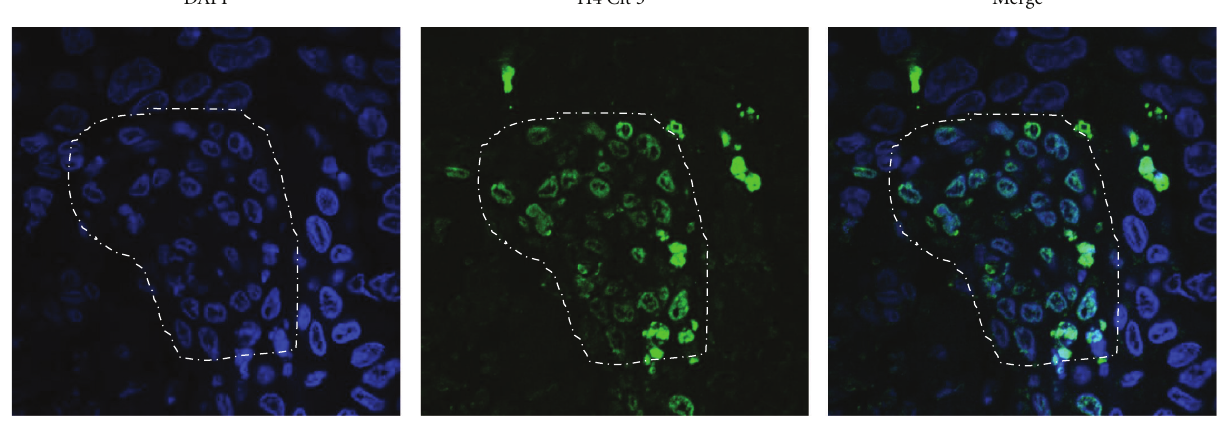
Figure 3: H4cit3 immunostaining of DCIS xenograft sections. Dotted line demarcates the area adjacent to the central necrotic core of the comedo-DCIS lesion. (Magnification